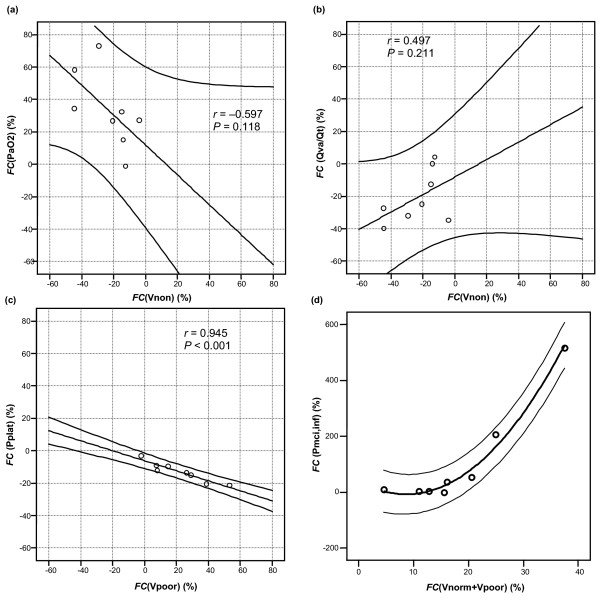
Correlation of the fractional changes (FC; %) of parameters with multi-slice CT lung volumes. Regression lines with 95% individual confidence intervals.(a) Insignificant correlation of arterial partial oxygen pressure (PaO2) with nonaerated lung. Note the large confidence intervals. (b) Insignificant correlation of venous admixture (QVA/QT) with nonaerated lung. (c) Close relation between changes in plateau pressure (PPLAT) and poorly aerated lung. (d) Pressure of maximum compliance increase on inflation curve (Pmci) correlates non-linearly with aerated volume (volume of normally aerated lung parenchyma (VNORM) + volume of poorly aerated lung parenchyma (VPOOR)). Note the sharp increase of Pmci beyond 20% increase in aerated lung volume.